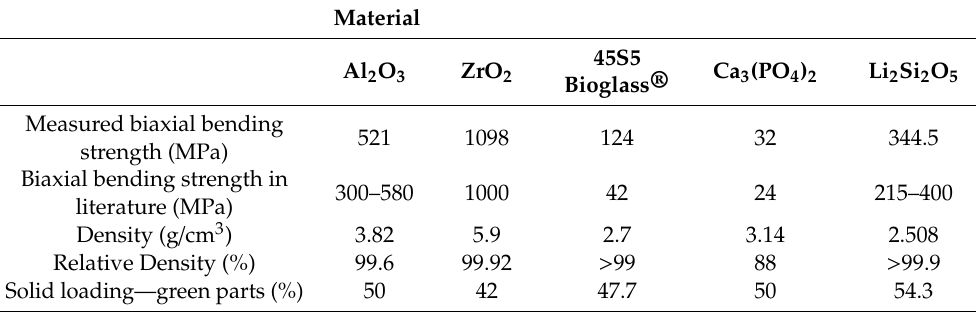
Material properties of di ff erent ceramics achieved with lithography-based ceramic manufacturing (LCM)